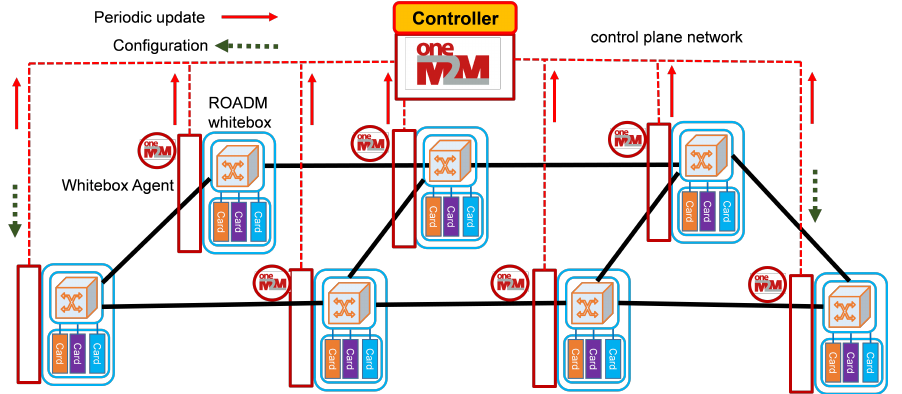
Figure 2. Reference scenario exploiting an OneM2M IoT platform for the SDN Control of optical